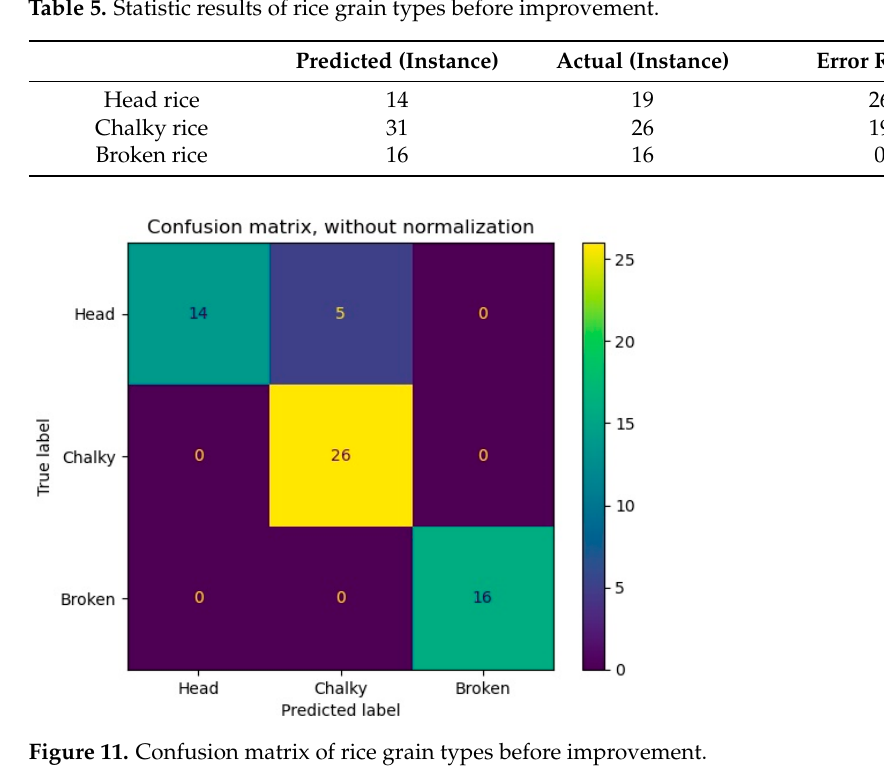
Figure 12. Image visualization of multiple rice grains. From the analysis of the model test results, YO-LACTS with strong robustness com- pleted the accurate segmentation of the rice grains under complex conditions, and further assessed their quality. By comparing the original image and the visual analysis image of the numbered rice grain (26) in Figure 13, it can be seen that overexposure in some areas of rice grain image caused the misjudgment of the rice grain type and chalky area: in order to reduce this error rate, the judgment of the exposure degree was added, and then tested on a new test set of 500 images. The identification results and confusion matrix are shown in Table 6 and Figure 14. The test results demonstrate that YO-LACTS achieves the accu- rate segmentation of rice grains, enabling researchers to evaluate their quality satisfacto- rily.